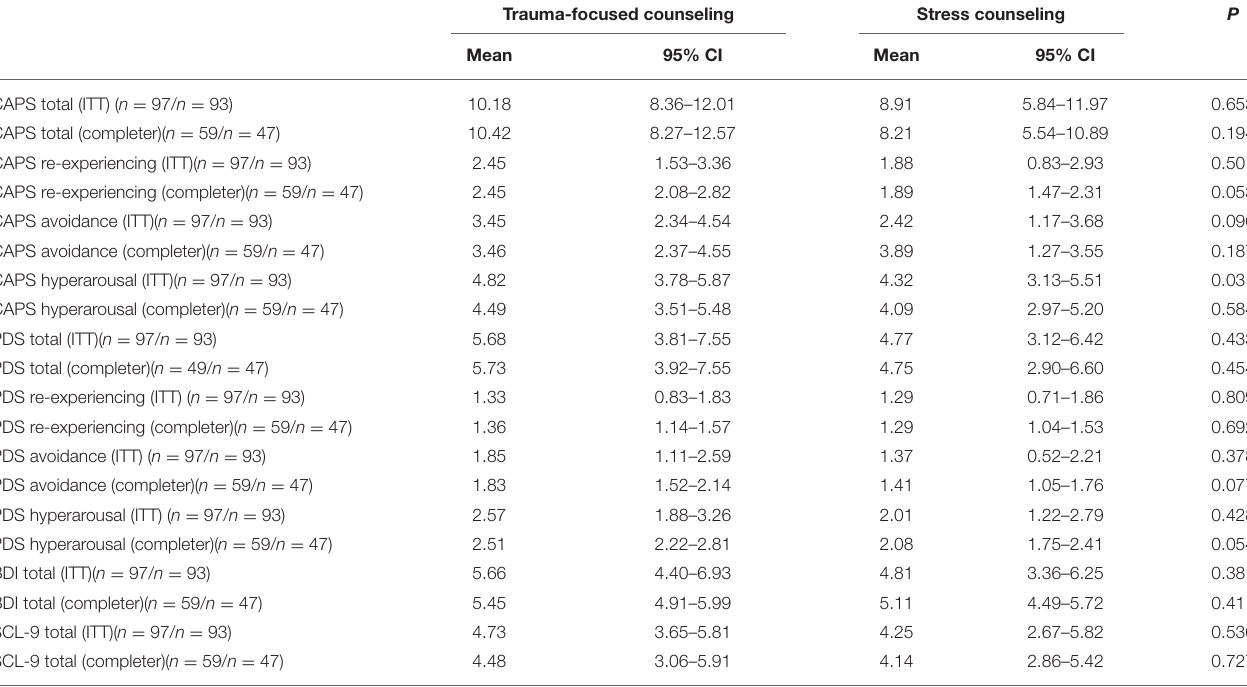
TABLE 2 | Differences in primary and secondary outcomes between types of interventions. Trauma-focused counseling Stress